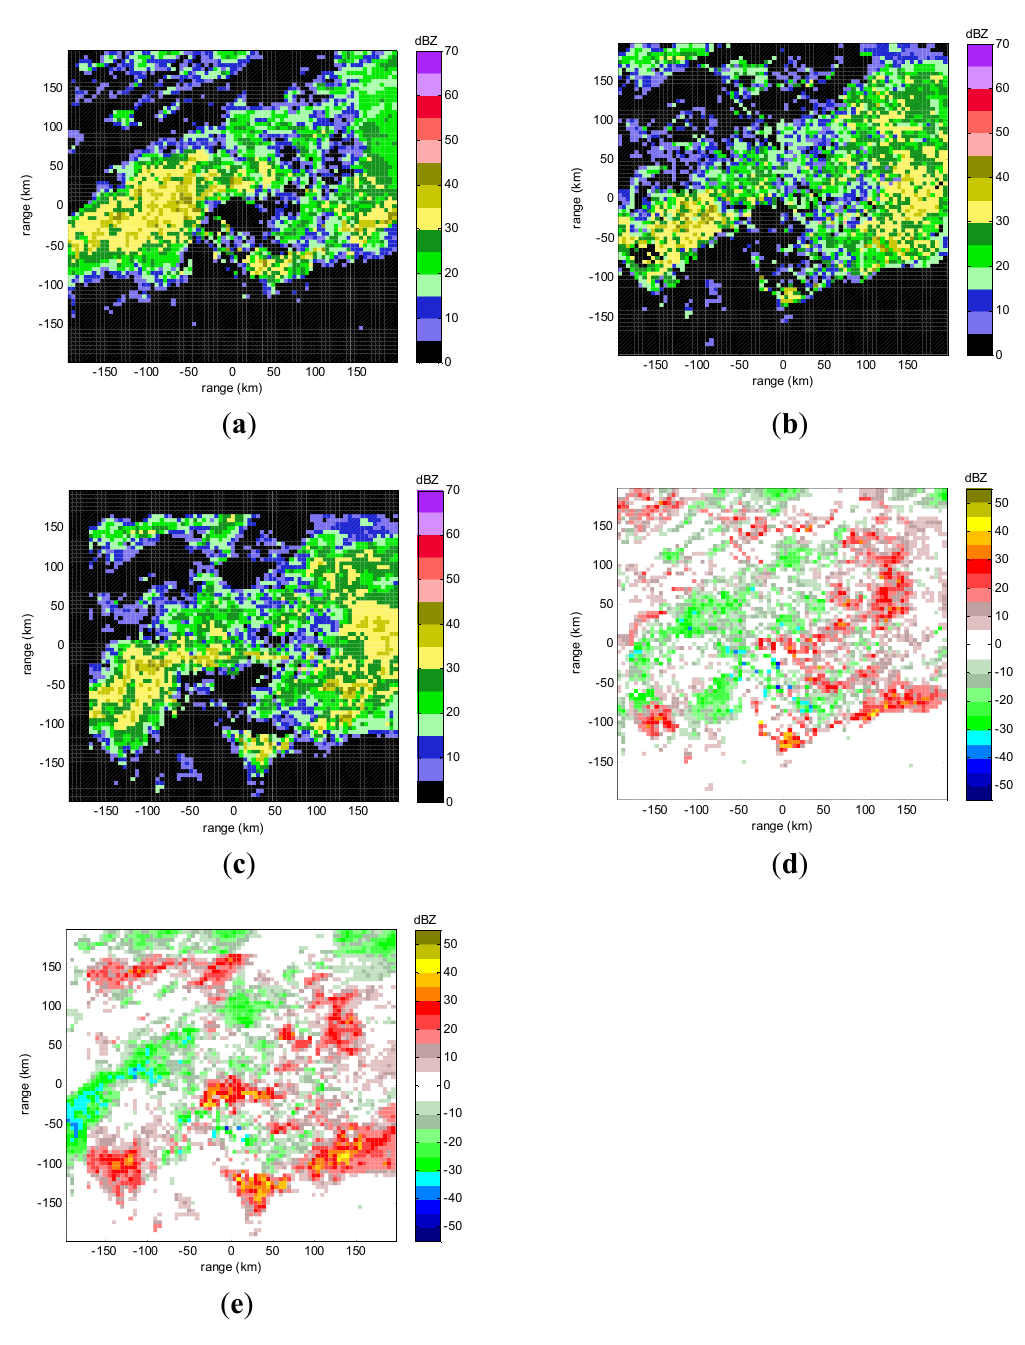
Figure 7. Radar reflectivity at 3 km height of the Nanjing case at 01:00 (UTC) on 12 July 2010 with radar station at origin (0,0). ( a ) actual reflectivity; ( b ) forecasting reflectivity by COTREC; ( c ) forecasting reflectivity by GVAD; ( d ) difference between forecasting reflectivity by COTREC and actual reflectivity; ( e ) difference between forecasting reflectivity by GVAD and actual